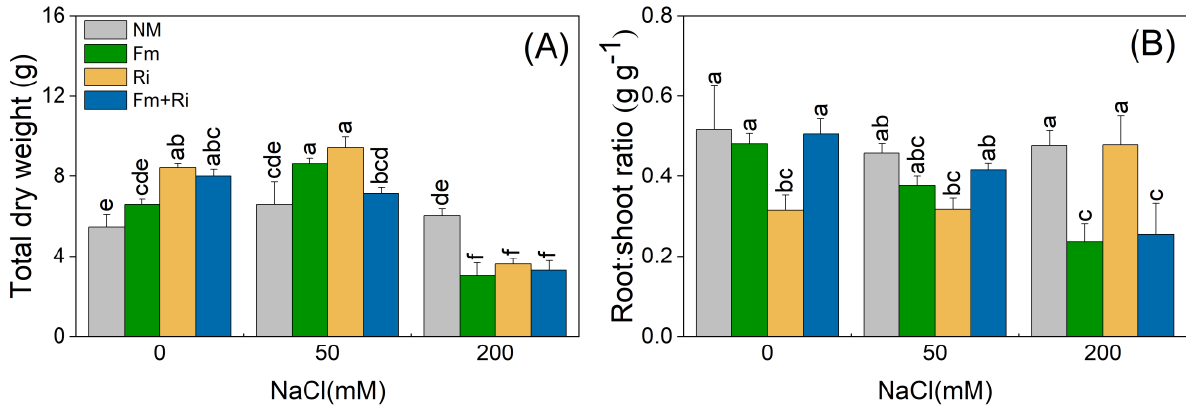
Figure 2. Effects of arbuscular mycorrhizal fungi on total dry weight ( A ) and root:shoot ratio ( B ) of Cinnamomum camphora plants under 0, 50, and 200 mM NaCl. NM, Fm, Ri, and Fm+Ri represent the four mycorrhizal treatments: inoculation with sterilized mycorrhizal fungi, with Funneliformis mosseae or Rhizophagus irregularis, either alone or in combination, respectively. Values are presented as the mean ± SE ( n = 6). Different lowercase letters indicate a significant difference according to LSD at p < 0.05.